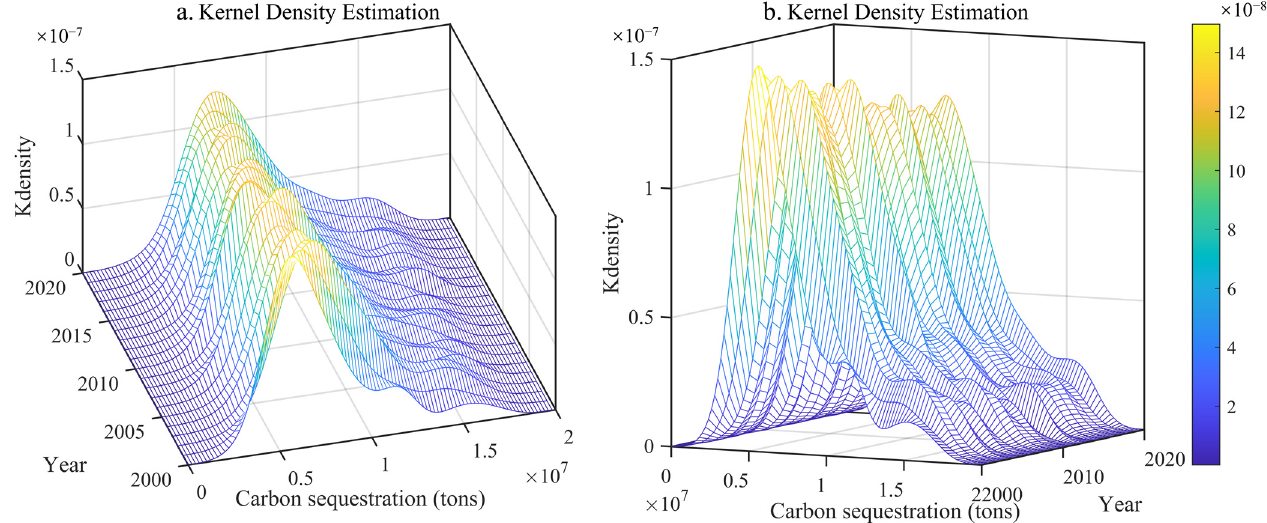
Figure 3. Kernel density estimates of forest vegetation carbon sequestration.